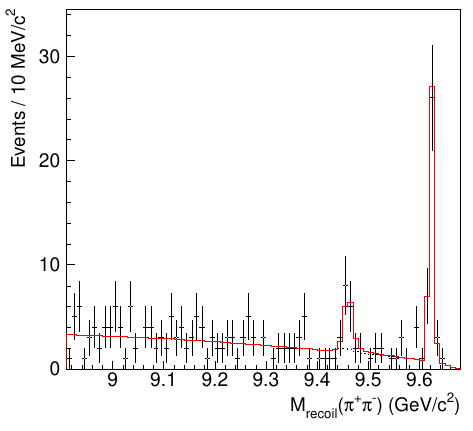
Figure 9 . The M recoil ( (cid:25) + (cid:25) (cid:0) ) distribution for (cid:22) + (cid:22) (cid:0) (cid:25) + (cid:25) (cid:0) events with an additional requirement of M ( (cid:25) + (cid:25) (cid:0) ) > 0 : 85 GeV =c 2 for the data sample at E c : m : = 10 : 52 GeV. The peak at 9 : 63 GeV =c 2 is due to the (cid:7)(2 S ) ! (cid:7)(1 S ) (cid:25) + (cid:25) (cid:0) transitions with ISR production of the (cid:7)(2 S ). Result of the (cid:12)t (red solid histogram) and the background component (black dotted histogram) are also